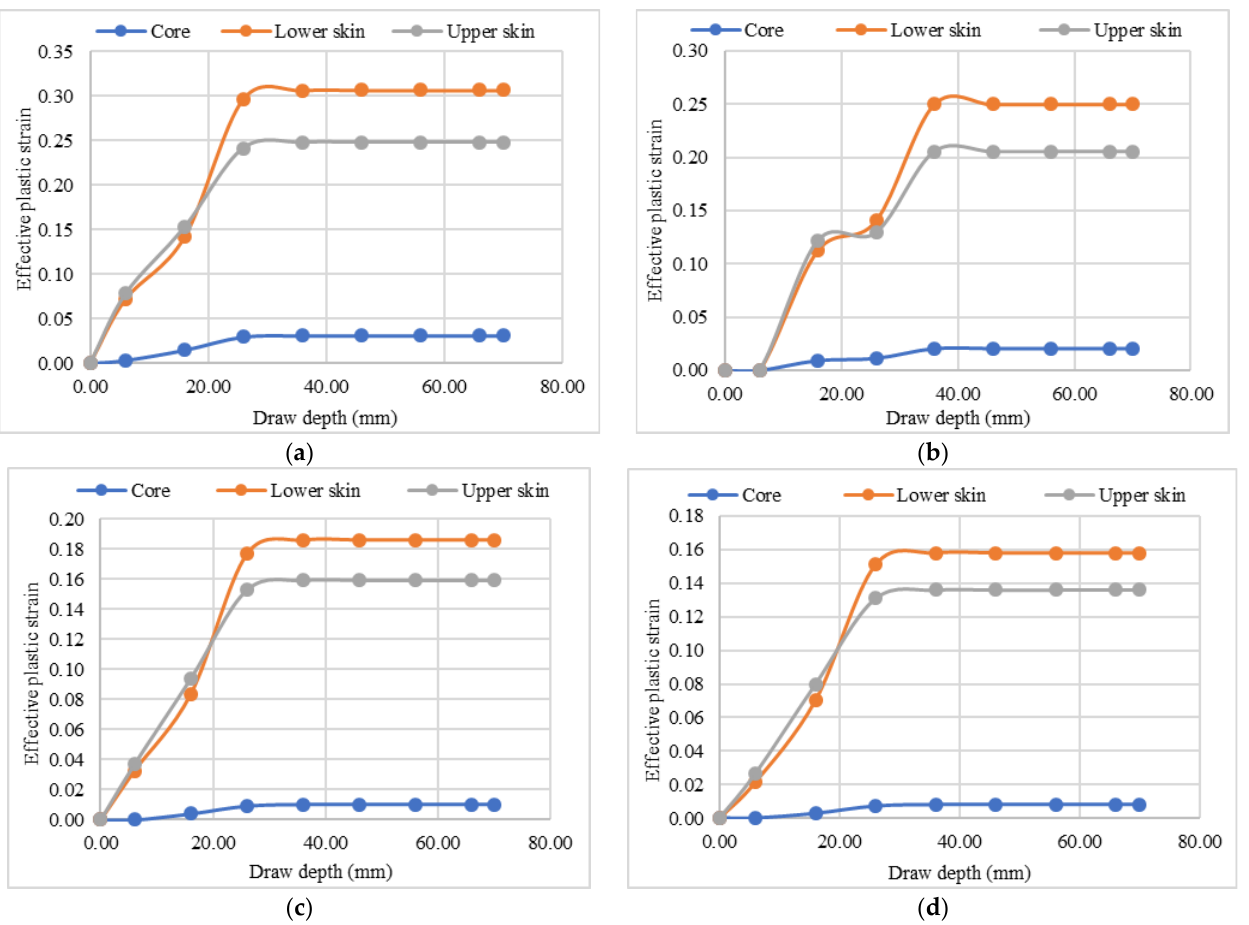
Figure 12. Effective plastic strains in sandwich laminates at the end of 70 mm draw depth. The thickness combinations are ( a ) 0.24/1.9/0.24 mm ( b ) 0.24/1.6/0.24 mm ( c ) 0.24/1.0/0.24 mm ( d ) 0.24/0.8/0.24 mm. Table 7. List of tool design and process parameters studied for springback of Al/PP/Al sandwich laminates.